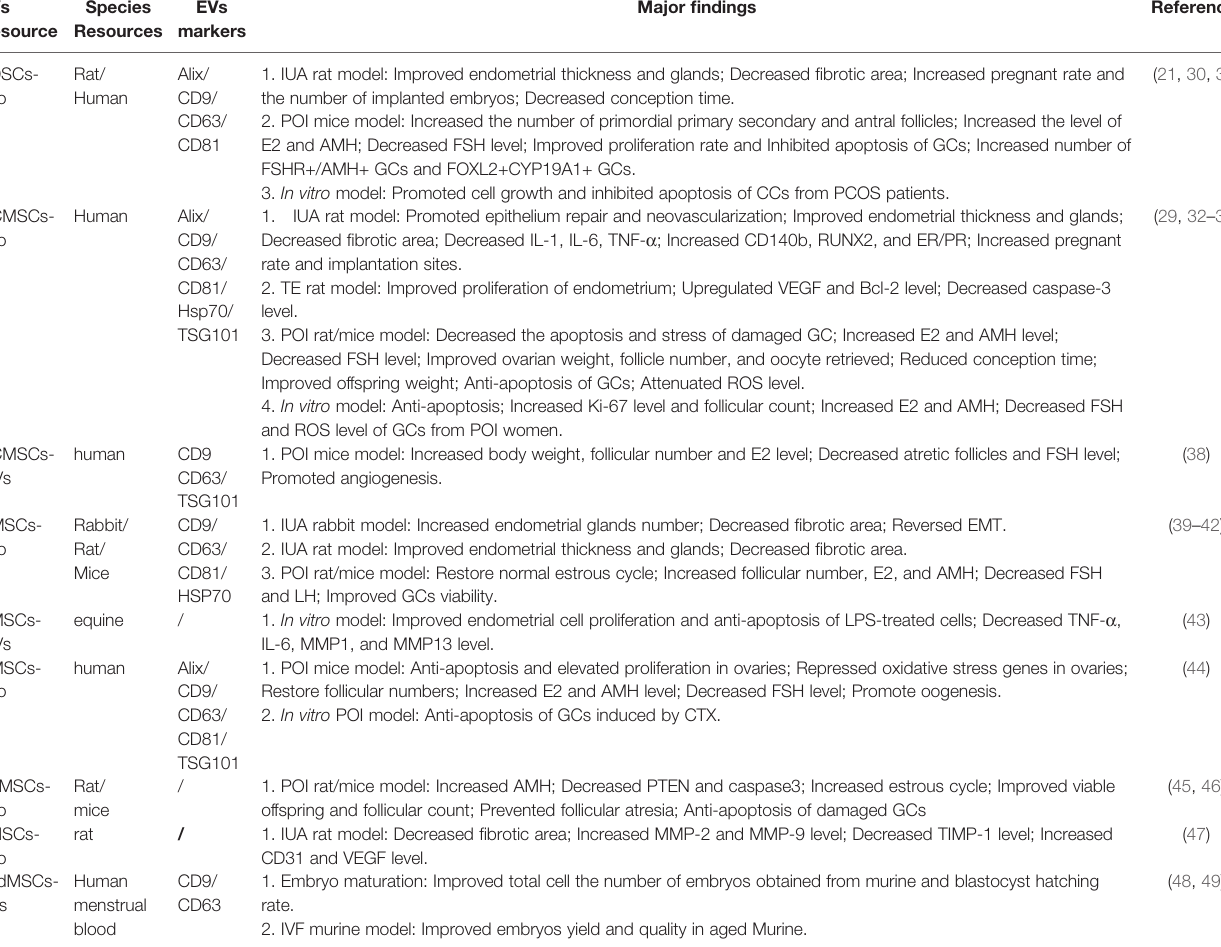
TABLE 1 | Markers and therapeutic effects of reported MSC-derived EVs which contribute to ameliorating female reproductive disorders. EVs